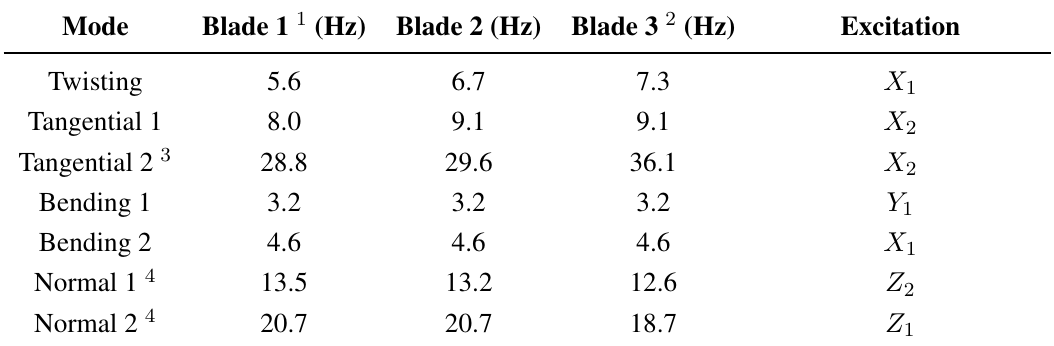
Figure 7. Turbine natural frequencies: ( a ) excitation; ( b ) modes of modes of movement. Table 4. Measured natural frequencies of the blade assemblies. The excitations and modes are illustrated in Figure